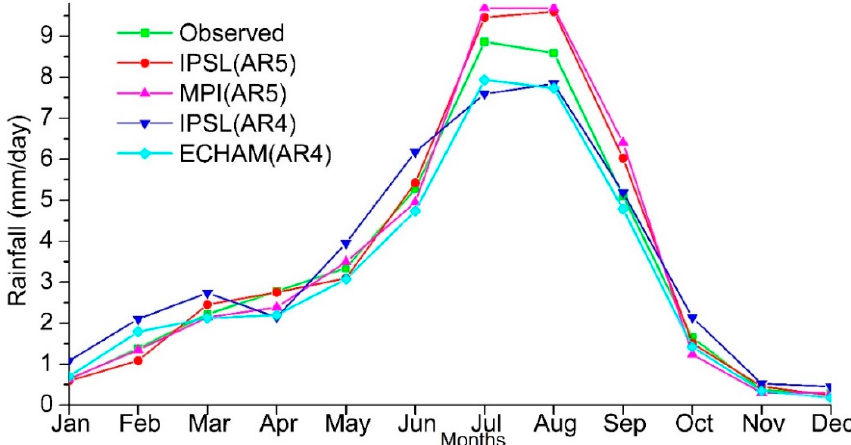
Figure 7. Observed monthly rainfall (1990–2011) and GCMs baseline (1971–2000).